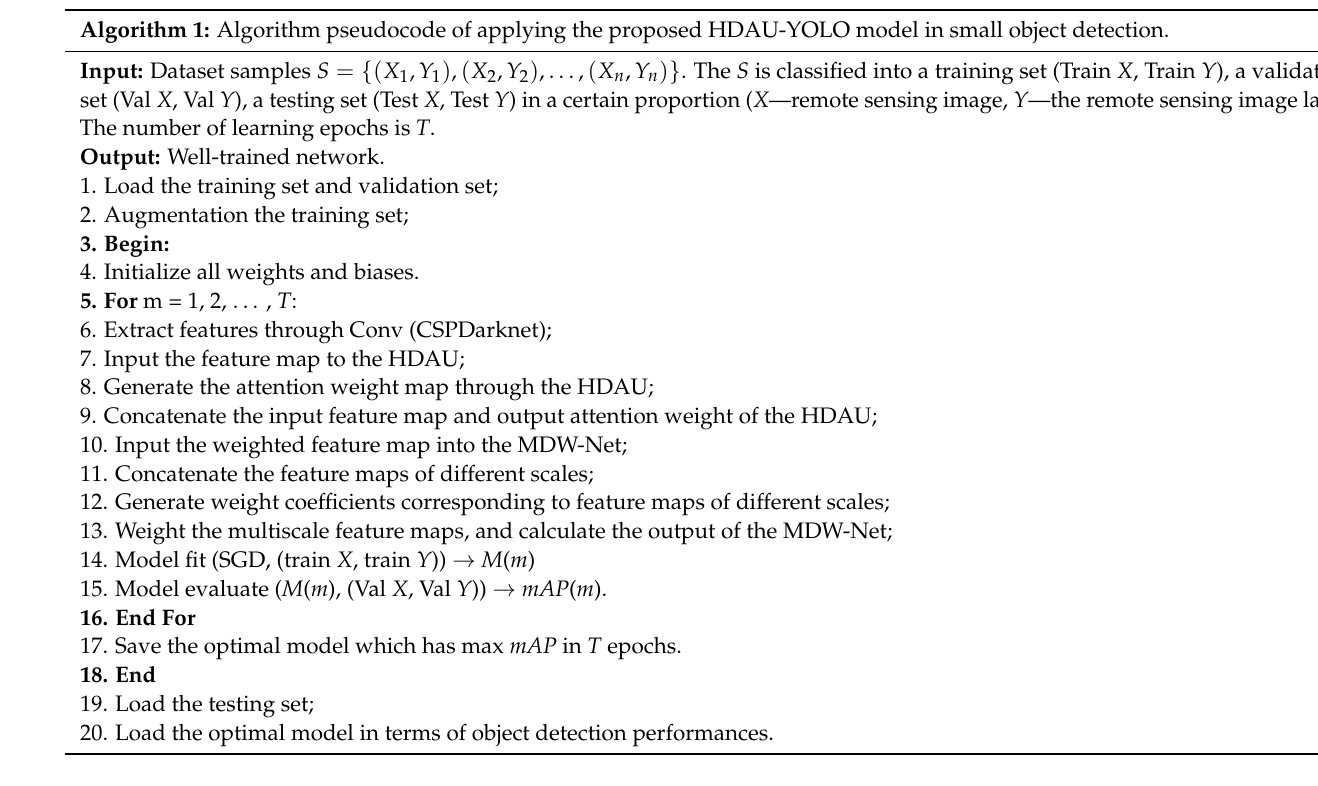
Algorithm 1: Algorithm pseudocode of applying the proposed HDAU-YOLO model in small object detection. Input: Dataset samples S = { ( X 1 , Y 1 ) , ( X 2 , Y 2 ) , . . . , ( X n , Y n ) } . The S is classified into a training set (Train X , Train Y ), a validation set (Val X , Val Y ), a testing set (Test X , Test Y ) in a certain proportion ( X —remote sensing image, Y —the remote sensing image